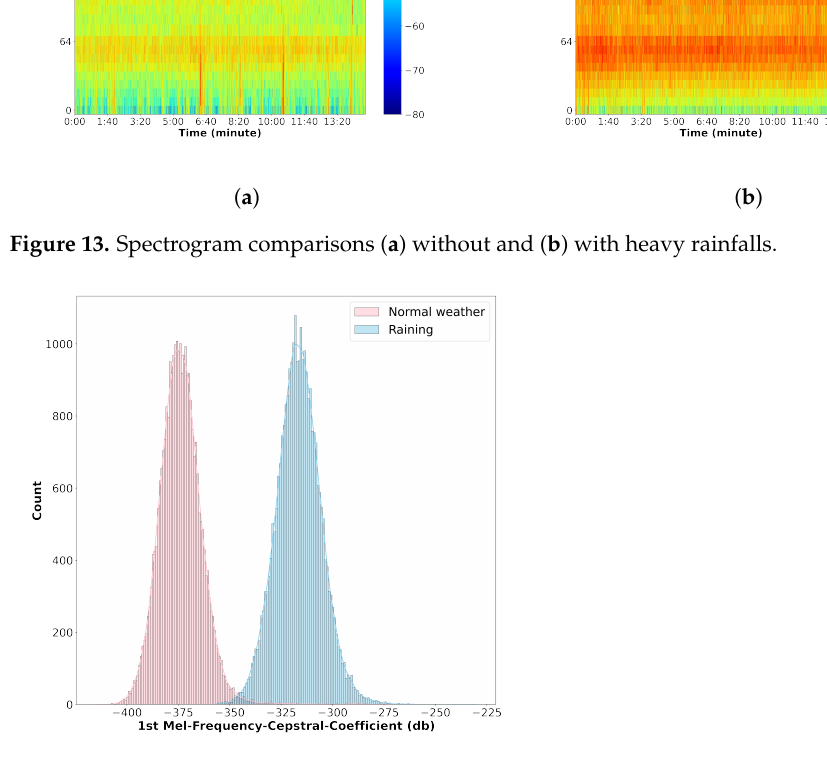
Figure 14. Comparison of the first MFCC histogram with and without